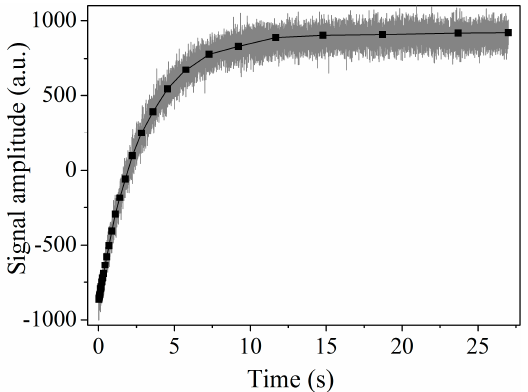
Figure 10. Comparison of Inversion recovery (IR) (black points) and Continuous Wave Free Precession- 𝑇 (cid:2869) (CWFP- 𝑇 (cid:2869) ) (grey line) normalized signals of water sample. Adapted from Publication [23] , Copyright (2016), with permission from Elsevier.